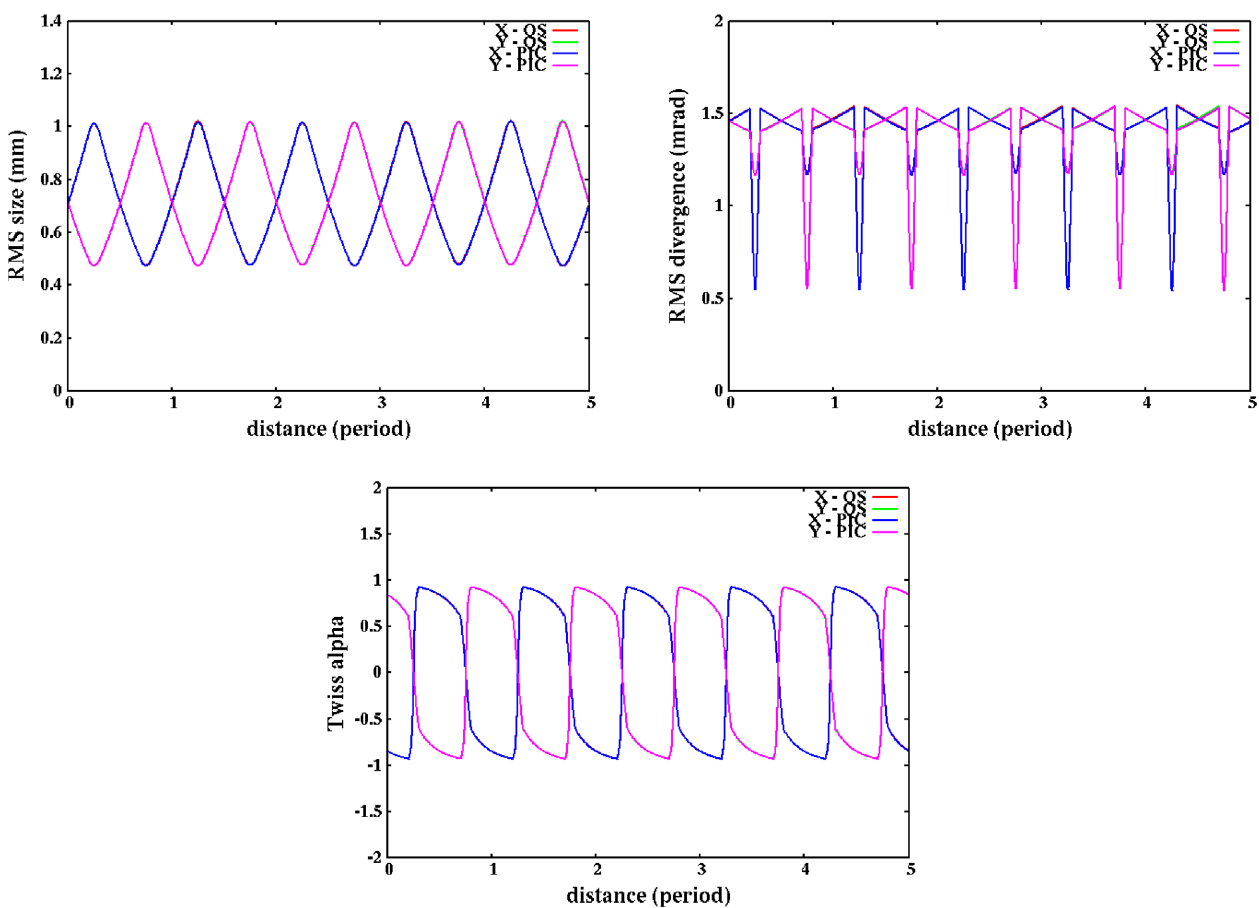
FIG. 4. Horizontal (x) and vertical (y) rms size (top left), rms momentum (top right), and beam Twiss alpha parameter (bottom) evolution through a five period FODO lattice from the quantum Schrödinger method (red and green) and from the PIC method (blue and magenta) with the space-charge effects.